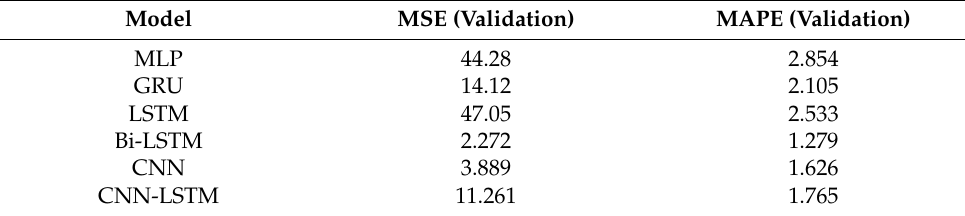
Table 13. The validation results of the models using Tesla data with six input features.